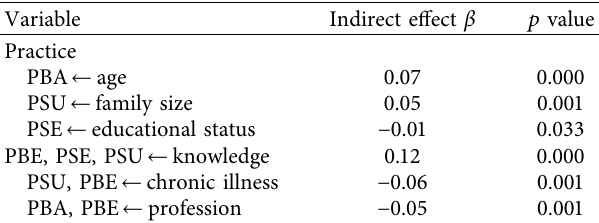
Table 4: Standardized indirect and the total effect of socio- demographic and other factors on prevention practice of academic staff of the University of Gondar, Ethiopia,